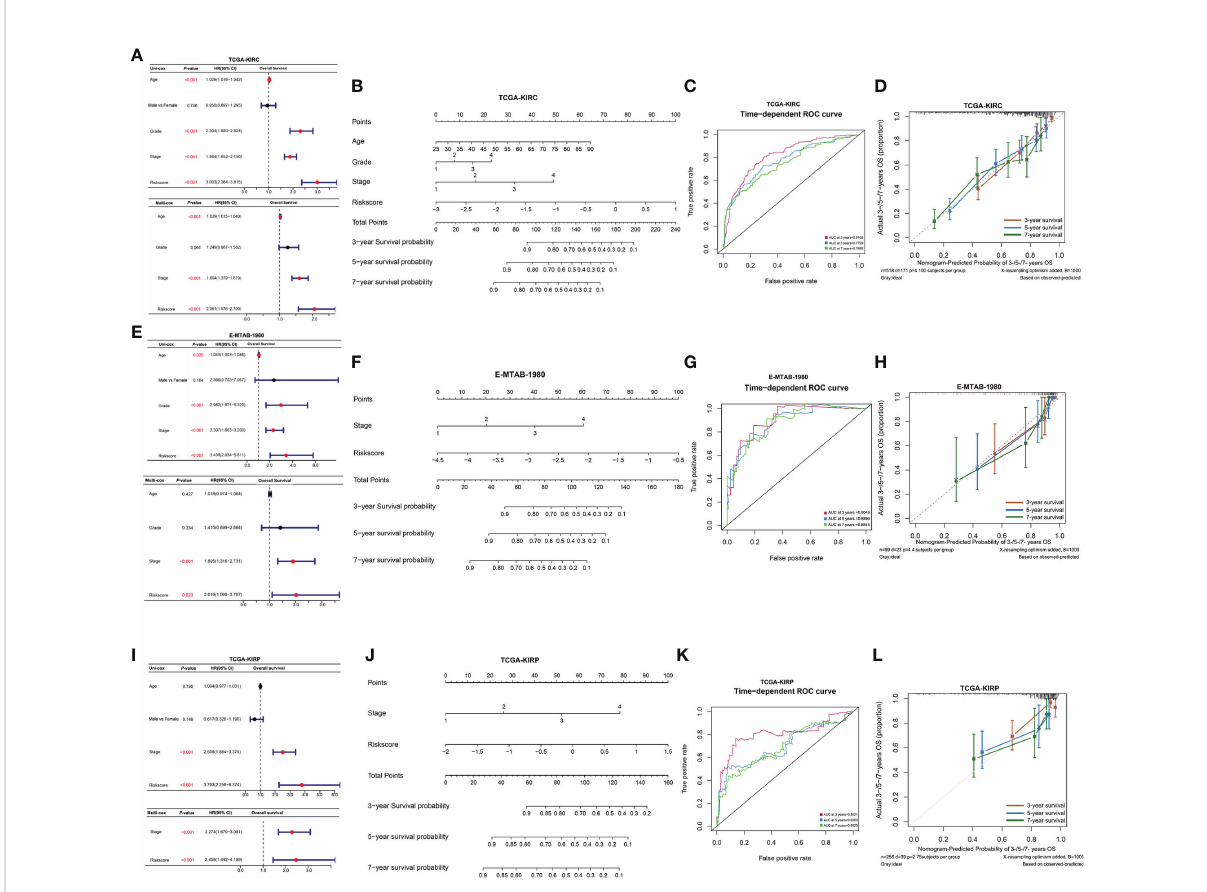
FIGURE 5 Clinical model construction of NPRGss-risk signature. (A) Univariate/multivariate Cox regression analysis regarding the OS in the TCGA-KIRC cohorts. (B) Nomogram model in TCGA-KIRC cohort. (C) The ROC curves of the nomogram model in the TCGA-KIRC cohort. (D) Calibration curves of OS probability over 3, 5, and 7 years based on nomogram model in TCGA-KIRC cohort. (E – H) Univariate/multivariate Cox regression analysis, nomogram construction, ROC curve analysis, and calibration curve analysis in the E-MTAB-1980 cohort. (I – L) Univariate/multivariate Cox regression analysis, nomogram construction, ROC curve analysis, and calibration curve analysis in the TCGA-KIRP cohort, ns, no signi fi